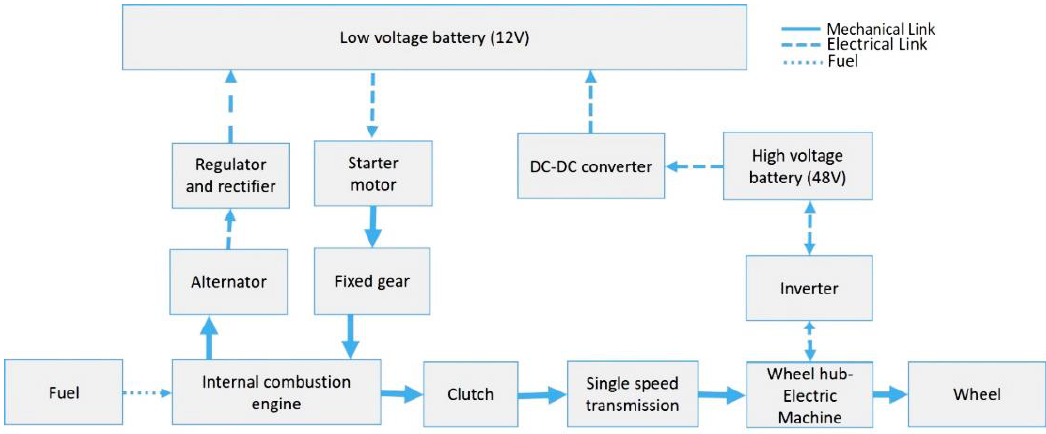
Figure 1. Vehicle powertrain architecture of the hybrid two-wheeler considered.